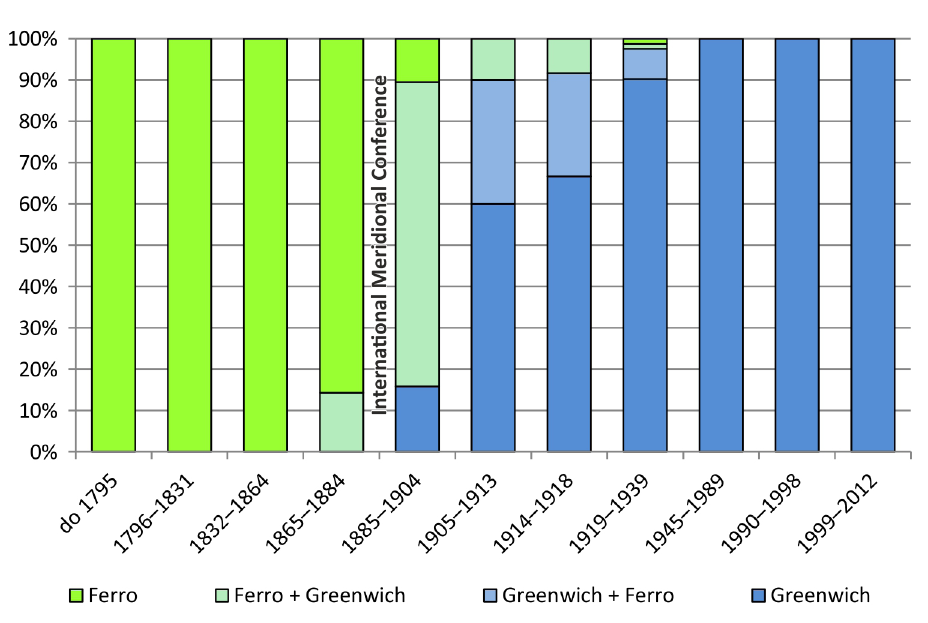
Fig. 2. The structure of atlases in the particular historical periods according to the Prime Meridian used on the maps (one case of using the Warsaw Meridian, 1908, is not included). The Paris Meridian is included into the Ferro longi - tude system. If two meridians are indicated, one that predominates in the atlas is the first one to be